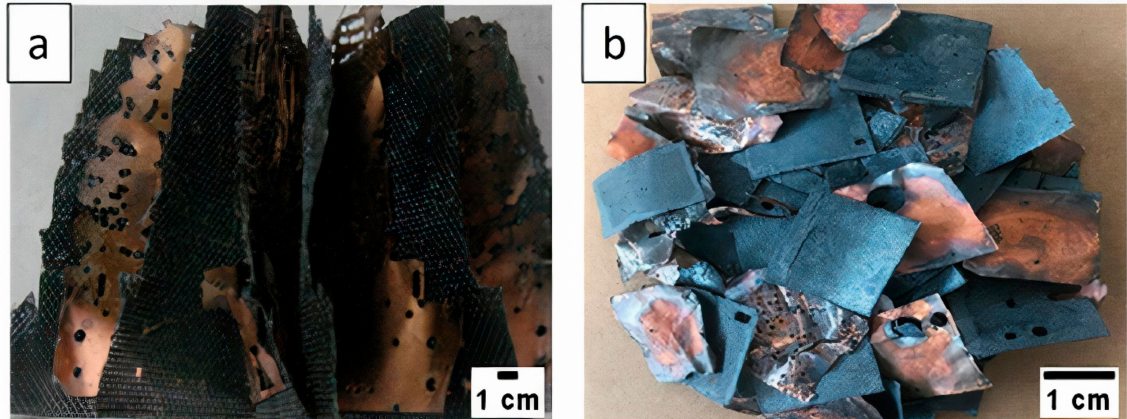
Figure 4. Resultant solid residue in coarse particle based pyrolysis: ( a ) unseparated pyrolytic solid residue—Reused from [57] with permission from Journal of Analytical and Applied Pyrolysis, ( b ) separated pyrolytic solid residue—Reused from [72] with permission from Science of the Total